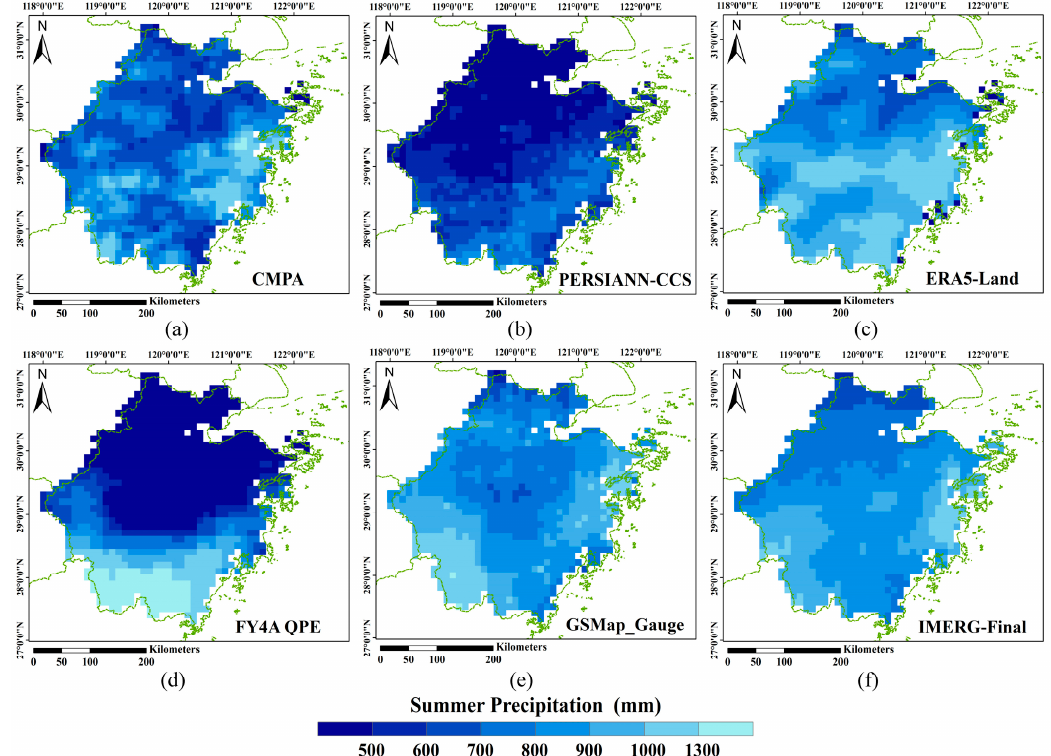
Figure 2. Spatial patterns of total precipitation based on ( a ) CMPA, ( b ) PERSIANN-CCS ( c ) ERA5-Land, ( d ) FY4A QPE ( e ) GSMap_Gauge, and ( f ) IMERG-Final over the Zhejiang province in summer, from June to August 2019.